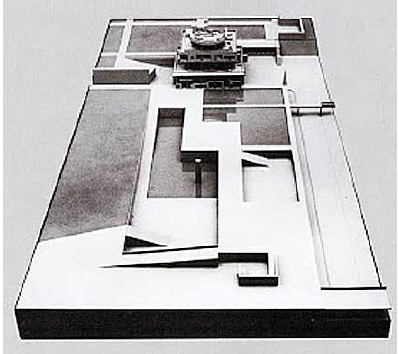
fig. 8b. Governors Palace, development of garden and